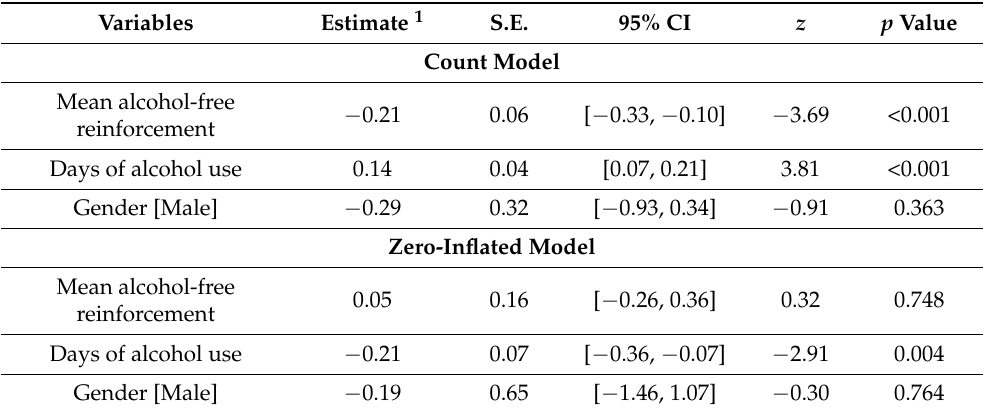
Table 3. Association between mean alcohol-free reinforcement and days of alcohol and cannabis